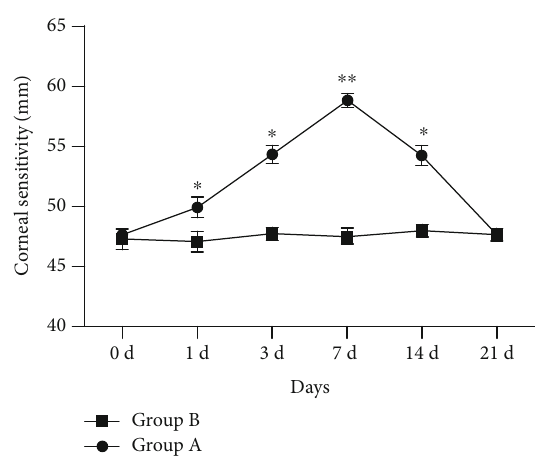
Figure 1: Corneal sensitivity of non-surgical eyes in group A and second-eye in group B. Group A: monocular phacoemulsi fi cation; Group B: blank